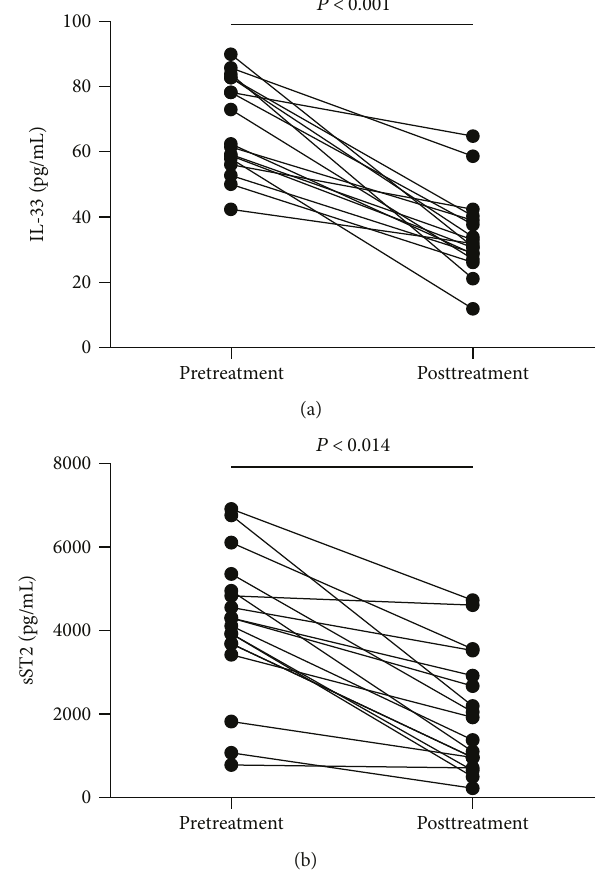
Figure 4: Serum levels of serum IL-33 and sST2 in AIH patients following treatment. (a) Serum levels of IL-33 in 17 AIH patients pre- and posttreatment; (b) serum levels of sST2 in 17 AIH patients pre- and posttreatment. Data shown are the mean levels of each serum cytokine in individual subject from two separate experiments. The horizontal lines indicate the mean values for the di ff erent